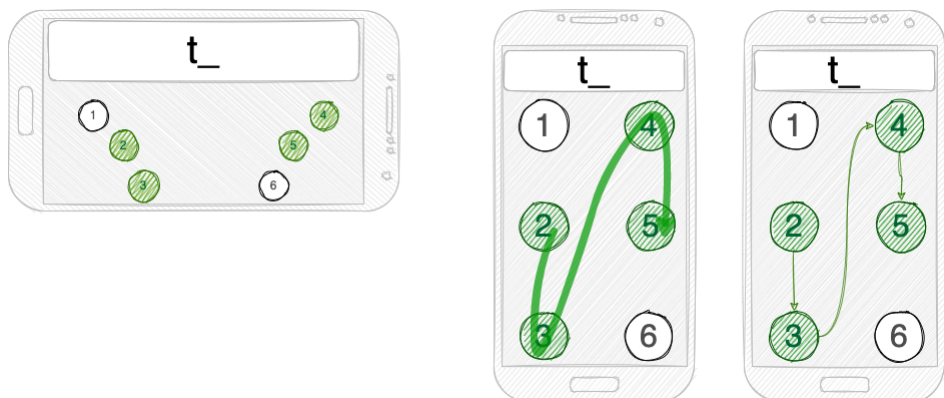
Figure 2. Examples of Braille input interaction styles using touchscreens.